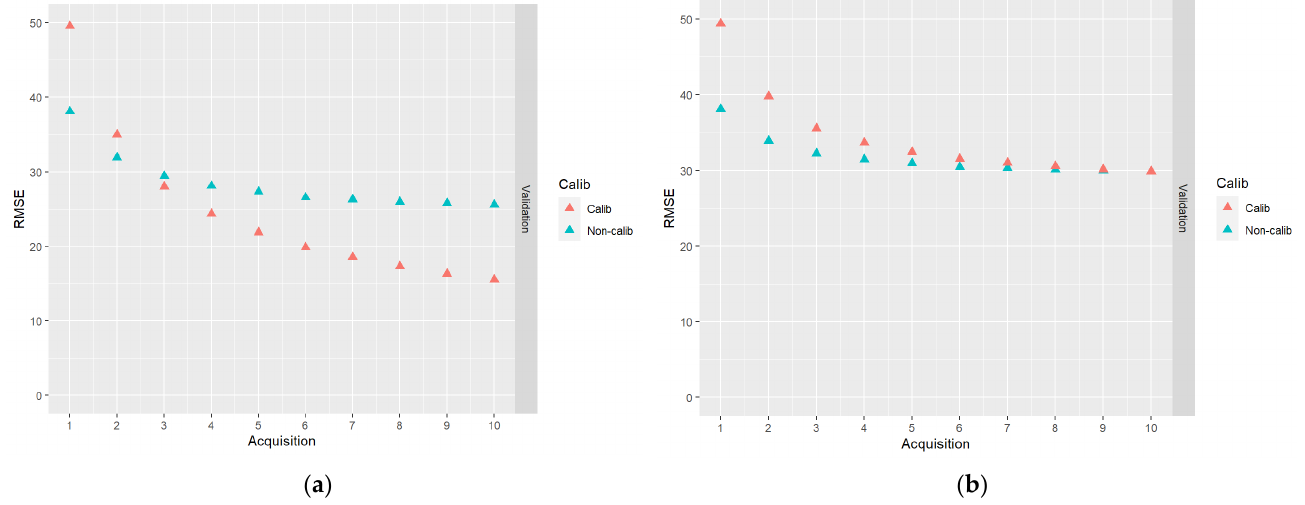
Figure 7. The results of DA schemes applying a sequence of 10 acquisitions of DP data: ( a ) no cor- relations between model errors were simulated (case I); ( b ) correlations were simulated according to Table 2 (case II).